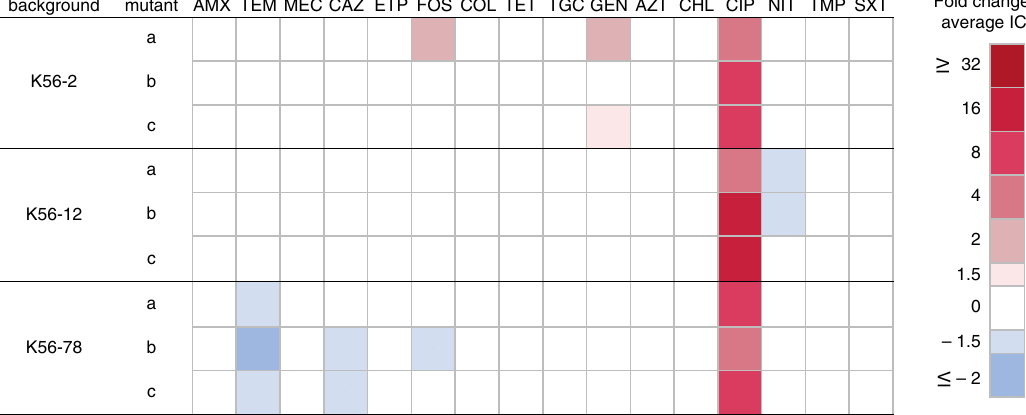
Fig. 2 Collateral effects in gyrA mutants with decreased susceptibility to cipro fl oxacin. Relative changes in antimicrobial susceptibilities, CS (blue) and CR (red), were determined by comparing average IC 90 values of nine fi rst-step mutants to their respective wild-type strain. Antimicrobials are ordered by antimicrobial class, as in Supplementary Fig. 2